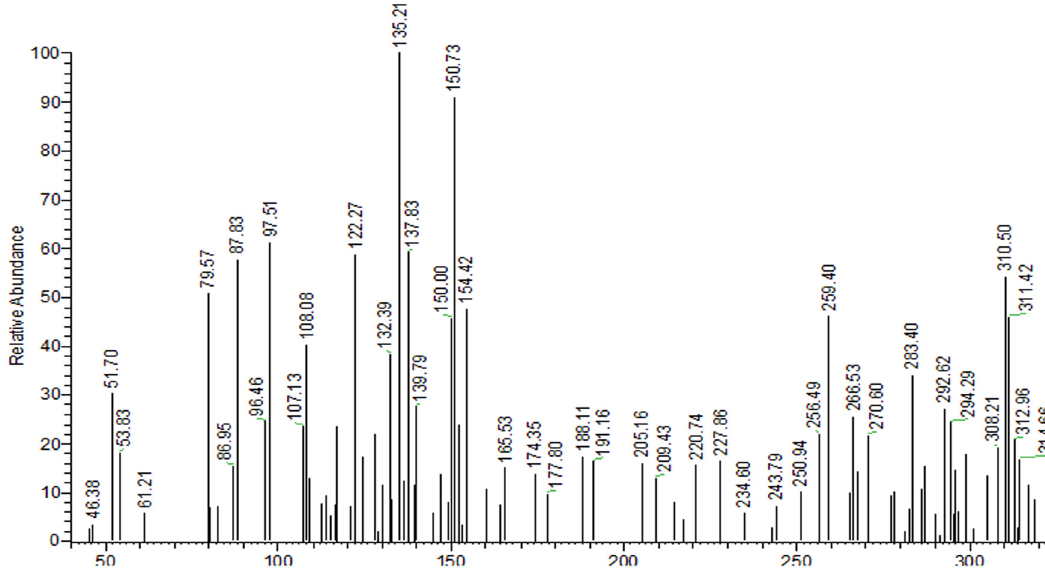
Figure 1: Mass spectrum fragmentations of the methoxy - diim